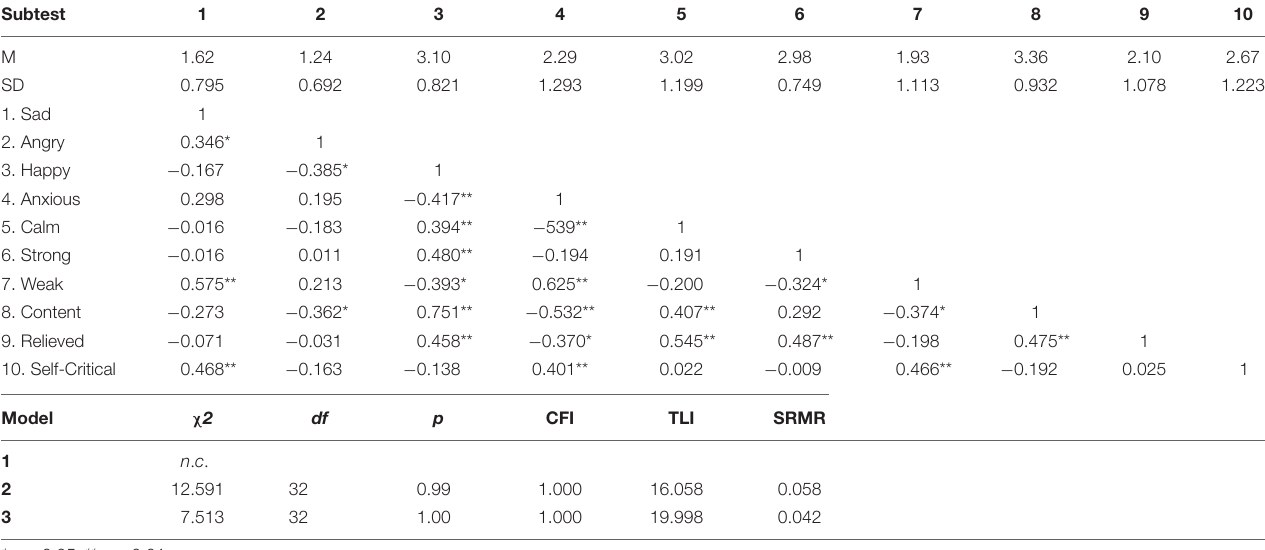
TABLE 1 | Correlations, means and standard deviations for visual analog scales (VAS) and goodness-fit indexes for the confirmatory factor analysis. Subtest